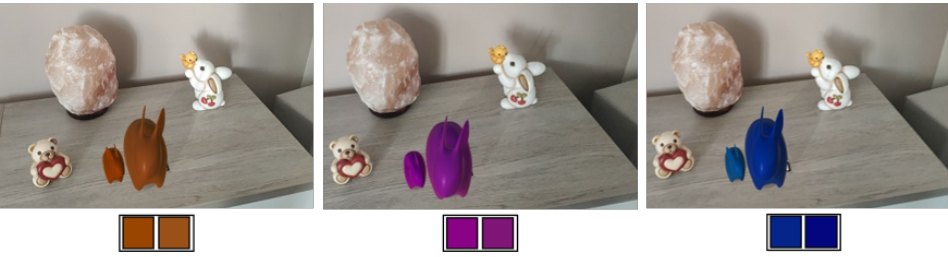
Figure 7. Recolored porcelain rabbit family by adopting the three strategies and the template Y.